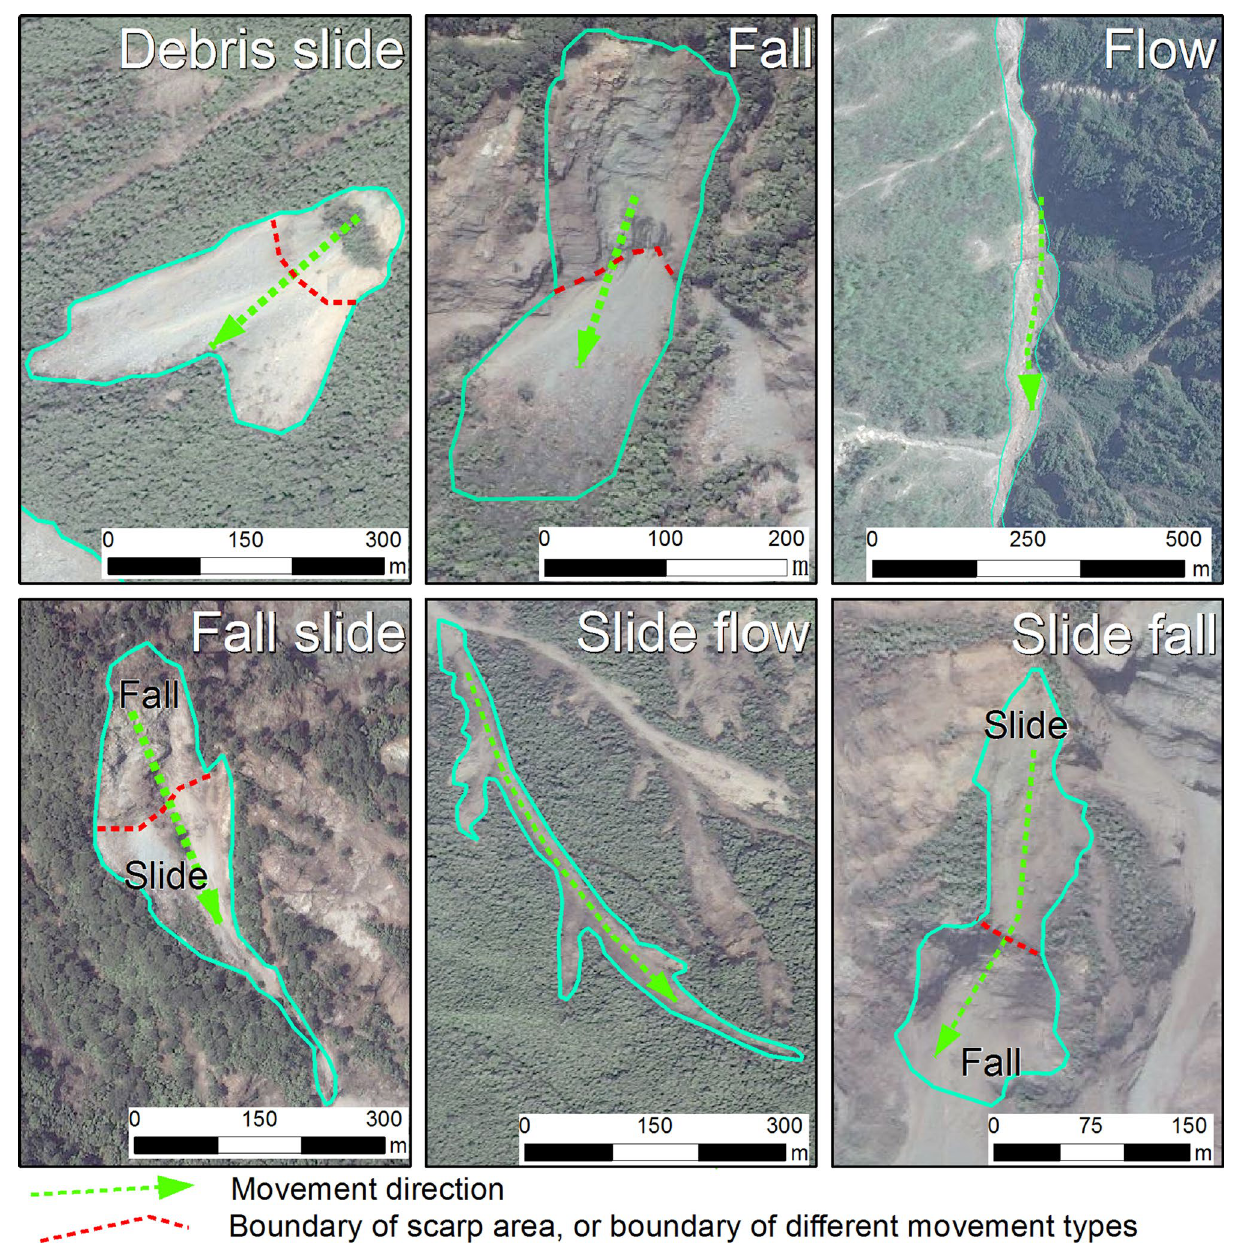
Figure 6. Examples of source materials movement types.Maps constructed using ArcGIS 10.2 (https:// deskt op. arcgis. com/